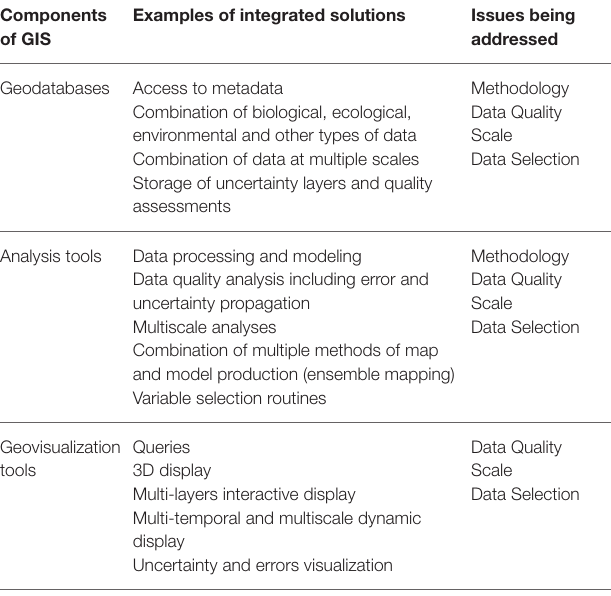
TABLE 4 | The different components of GIS that make them potential candidates for informing decision-making in marine conservation and management while facilitating awareness on the different issues highlighted in this